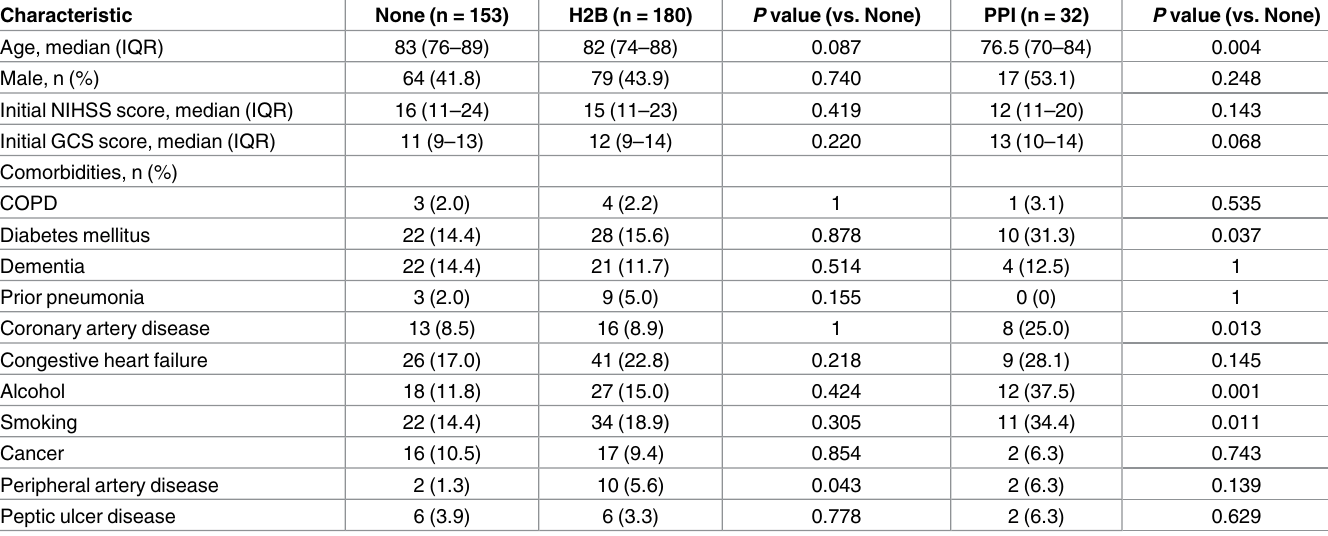
Table 1. Patient Characteristics.